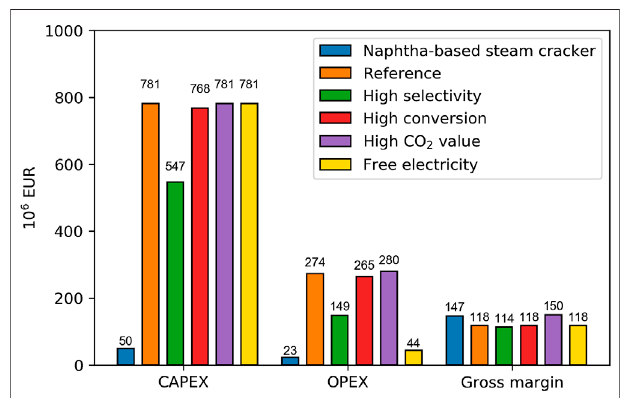
FIGURE 7 | Capital expenditure, Operational expenditure, and gross margin (in 10 6 € ) for the naphtha-based steam cracker, the reference electrochemical case, the high selectivity case, the high conversion case, the high CO 2 cost case and the free electricity case.